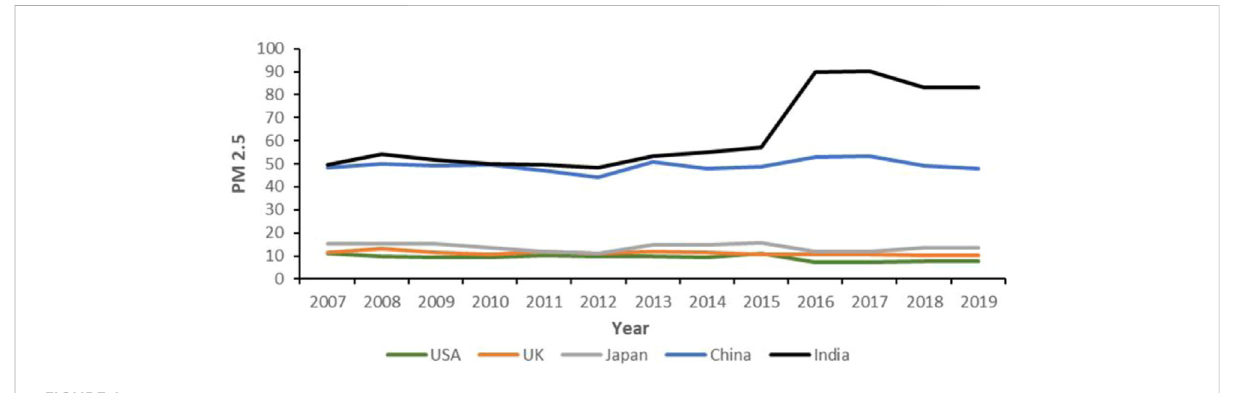
FIGURE 1 Average annual PM 2.5 concentration in some countries from 2007 to